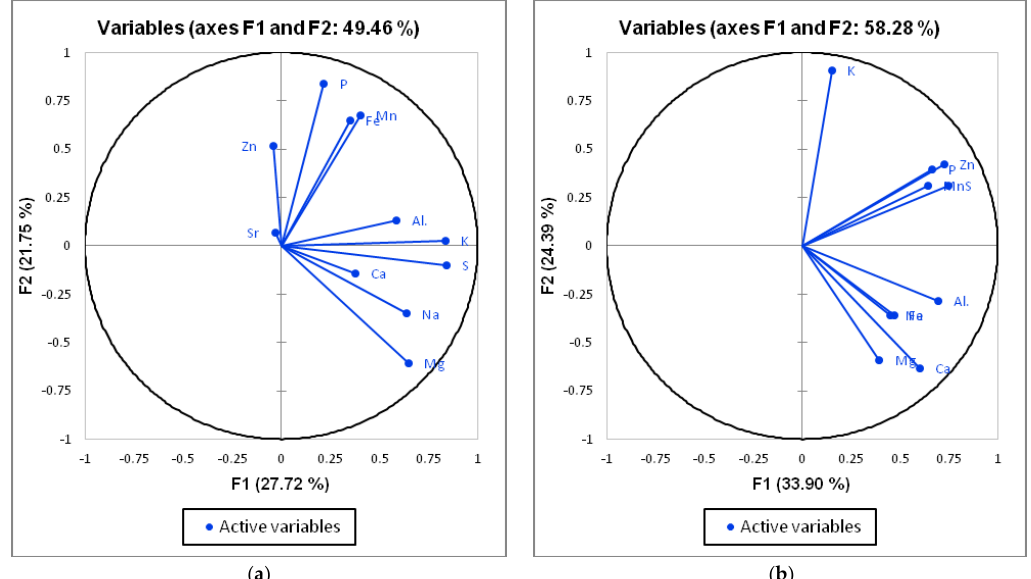
Figure 7. Variable plot in the system of the first two factor axes for the biomass of giant miscanthus after the first ( a ) and second ( b ) year of